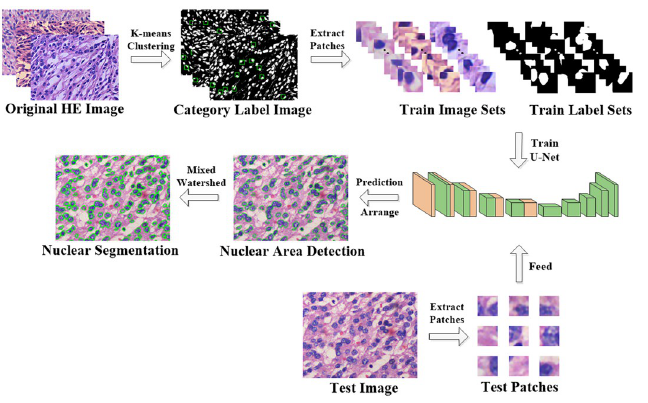
Fig 1. Workflow of the proposed HE image processing and analysis